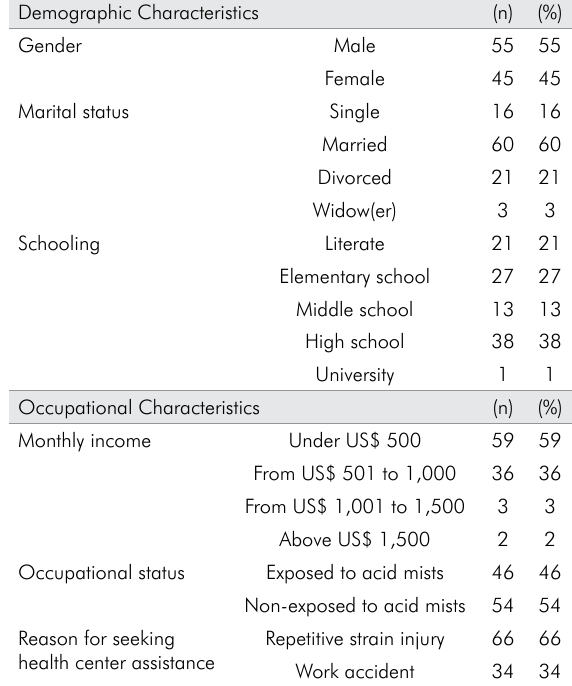
Table 1. Demographic and occupational characteristics of the study